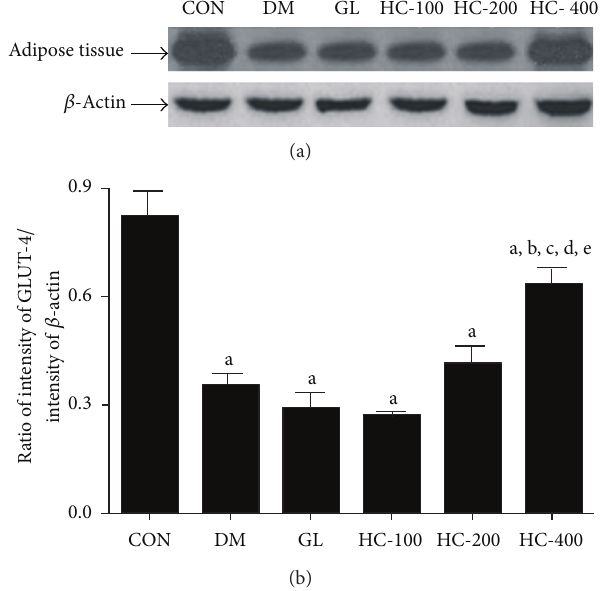
Figure 6: Effect of HC (100, 200 and 400 mg/kg) on STZ-induced changes in the levels of expression of GLUT-4 in adipose tissues. The blots (a) are representative of GLUT-4 in adipose tissues. The results in the histogram (b) are expressed as ratio of relative intensity of levels of protein expression of GLUT-4 to 𝛽 -Actin. All values are mean ± SEM of three separate sets of experiments. a 𝑃 < 0.05 compared to normal control; b 𝑃 < 0.05 compared to diabetic control; c 𝑃 < 0.05 compared to glibenclamide; d 𝑃 < 0.05 compared to HC 100; e 𝑃 < 0.05 compared to HC 200 (one-way ANOVA followed by Tukey’s multiple comparison test).